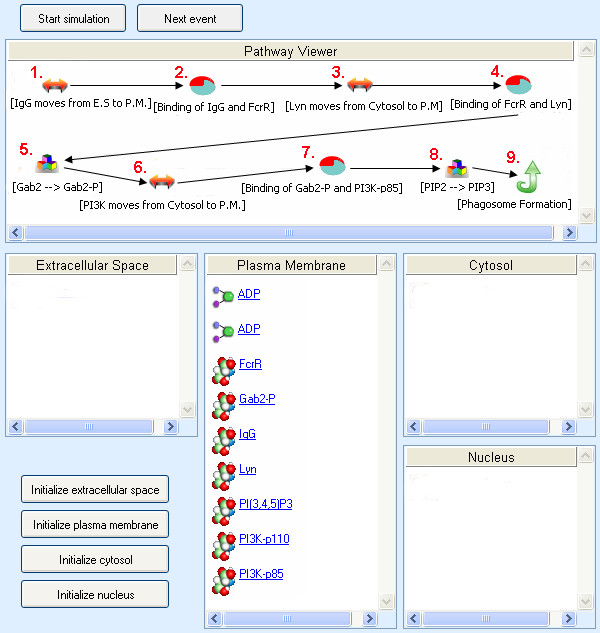
A SN- simulator: at the end of the simulation. The pathway-viewer shows that the initial translocation of the IgG molecule has led to the occurrence of a series of events, which include several non-covalent interactions, covalent interactions, and translocations of various molecules: Event #1: the IgG was translocated from the extracellular space to the plasma membrane. Event #2: the IgG bound to the Fcγ receptor at the plasma membrane. Event #3: the Lyn was translocated from the cytosol to the plasma membrane. Event #4: the Lyn bound to the Fcγ receptor at the plasma membrane. Event #5: the Lyn phosphorylated the Gab2 to a Gab2-phosphate (Gab2-P) at the plasma membrane. Event #6: the PI3K-p85 and p110 (already bound to each other) were translocated together from the cytosol to the plasma membrane. Event #7: the PI3K-p85 bound to the Gab2-P at the plasma membrane. Event #8: the PI3K-p110 phosphorylated the PIP2 to a PIP3 (PI[3,4,5]P3) at the plasma membrane. Event #9: The formation of the PIP3 caused phagosome formation.